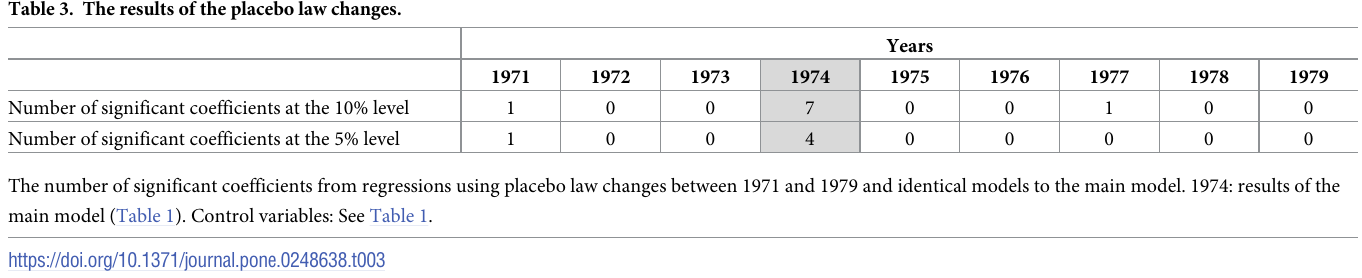
Table 3. The results of the placebo law changes.